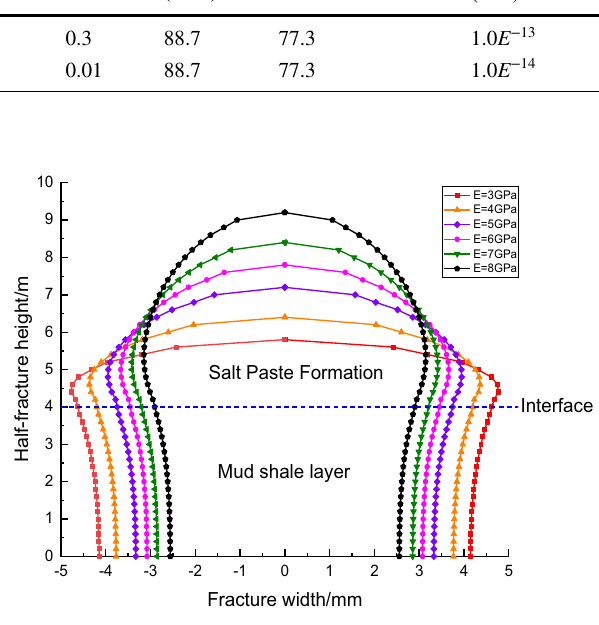
Fig. 18 The fracture morphology under different elastic modulus of